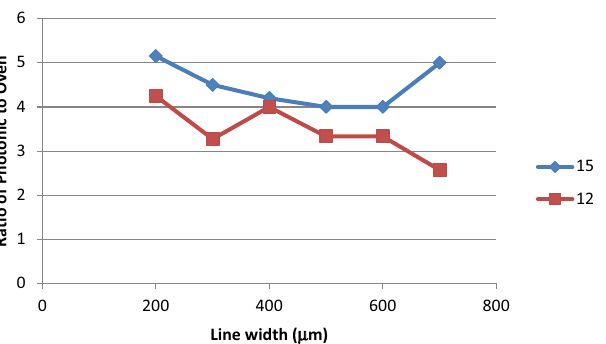
Figure 7. The impact of feature sizes and film thickness on the relative conductivity between the oven sintered and the photonically sintered printed lines for the 100N material.